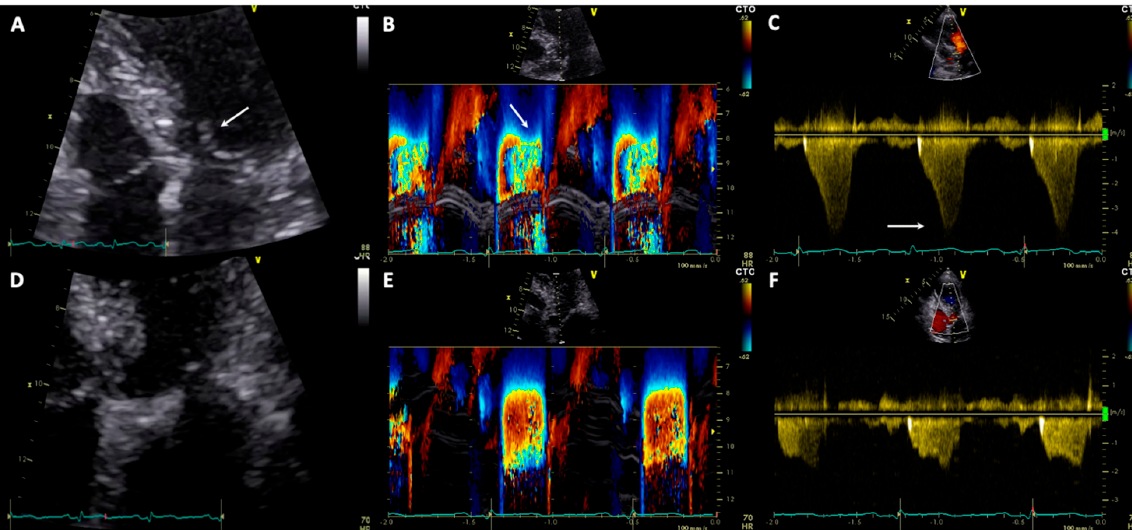
Figure 2. Panel ( A ) TTE with zoom on left ventricle outflow tract showing systolic anterior movement of anterior mitral leaflet during systole (see arrow); ( B ) Color M-Mode showing strong blood acceleration through left ventricle outflow tract in telesystole (see arrow); ( C ) CW-Doppler at TTE showing intraventricular peak gradient of 63 mmHg (see arrow); ( D ) TTE with zoom on left ventricle outflow tract showing absence of systolic anterior movement of anterior mitral leaflet during systole at recovery on day 6; ( E ) Color M-Mode showing regular blood acceleration through left ventricle outflow tract in telesystole at recovery; ( F ) CW-Doppler at TTE showing resolution of intraventricular gradient at recovery in the same patient. TTE: transthoracic echocardiography; CW: continuous